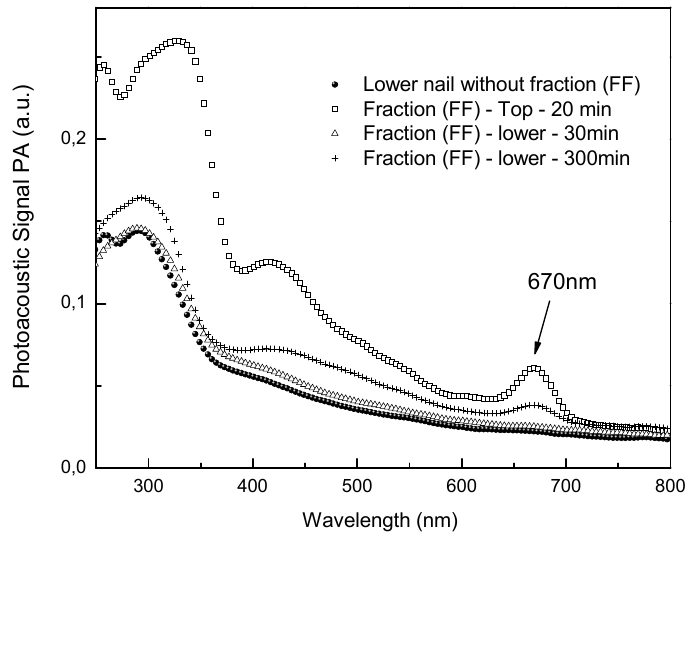
Figure 5. Photoacoustic Spectroscopy Measurement. after 20 min the FF fraction was detected at 670 nm. Spectra obtained with excitation performed in the nail. The light modulation frequency was 20 Hz. The inset highlights the presence of the FF fraction absorption in the spectrum. With this procedure the penetration depth in the nail (the thermal diffusion length) corresponds to about 670